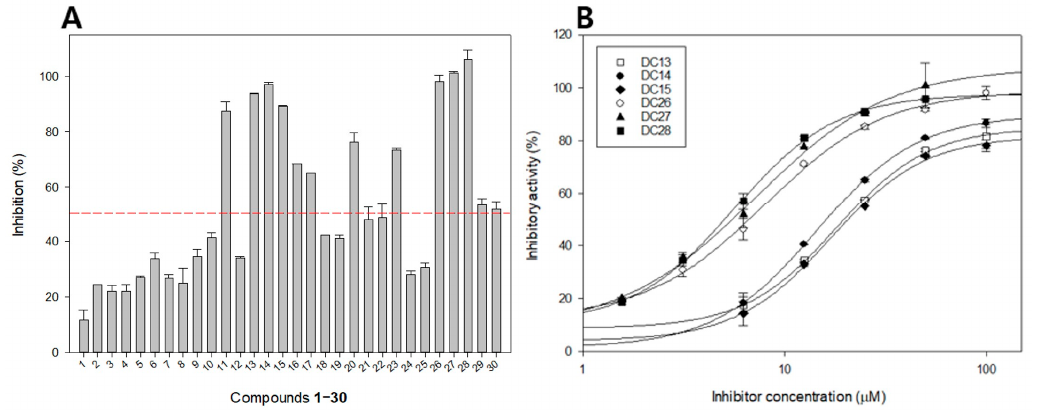
Figure 2. Inhibitory activity of compounds 1 – 30 at 100 μ M ( A ) and IC 50 values of active phloroglucinols 13 – 15 and 26 – 28 on β -glucuronidase ( B ).